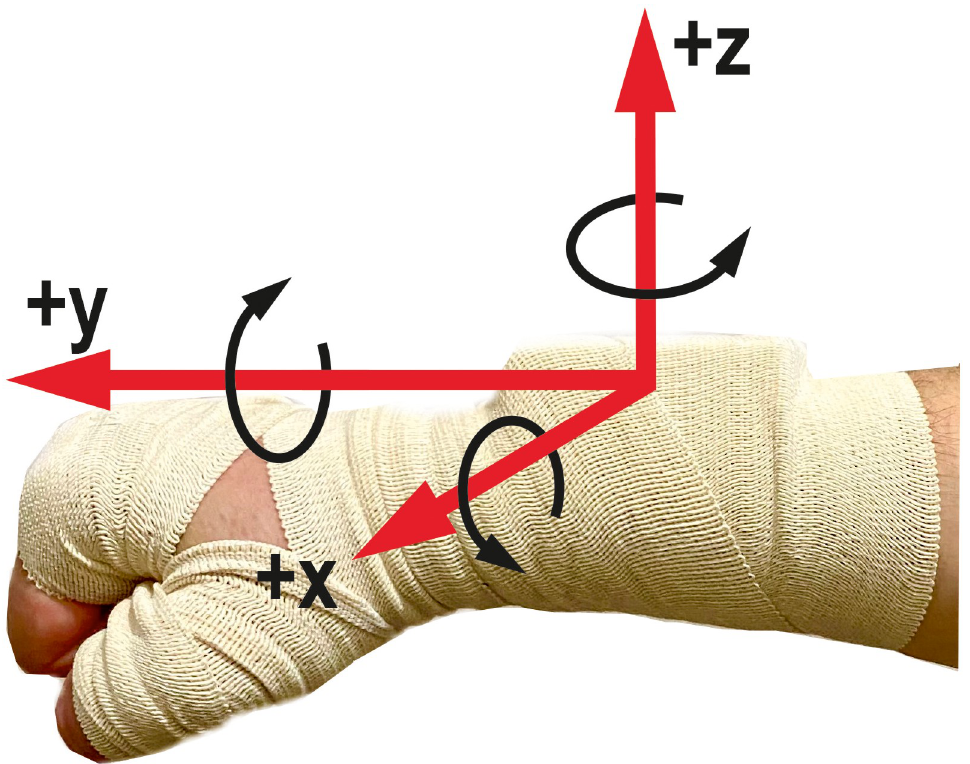
Fig 3. Measuring module attached to the arm with a boxing hand wrap. The positive directions of the accelerometer axes are shown, as well as the positive directions of angular rate.